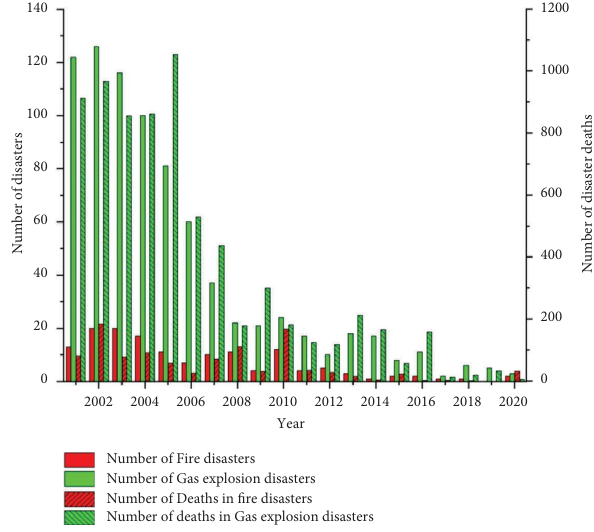
Figure 2: Coal mine disasters